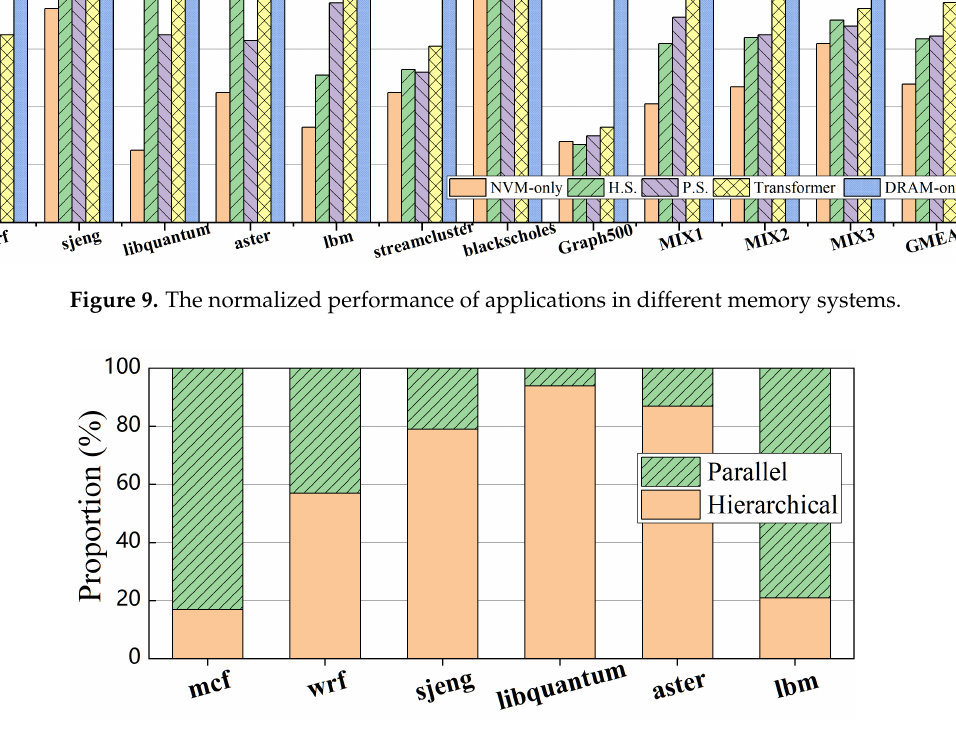
Figure 10. Execution time of different memory